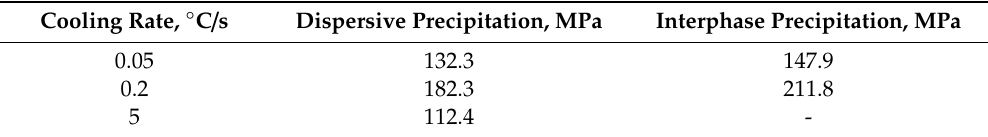
Table 2. The calculated precipitation strengthening e ff ects on mechanical properties of Cu-bearing steel depending on cooling